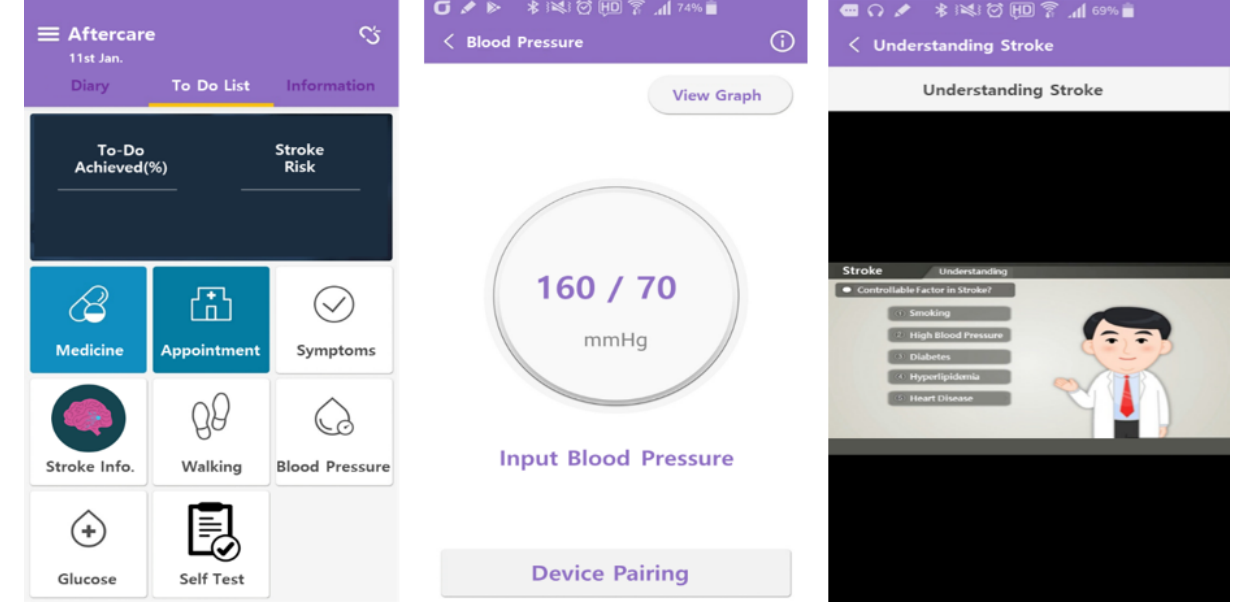
Figure 2. Image showing the entry screen (left), blood pressure recording (middle), and educational content